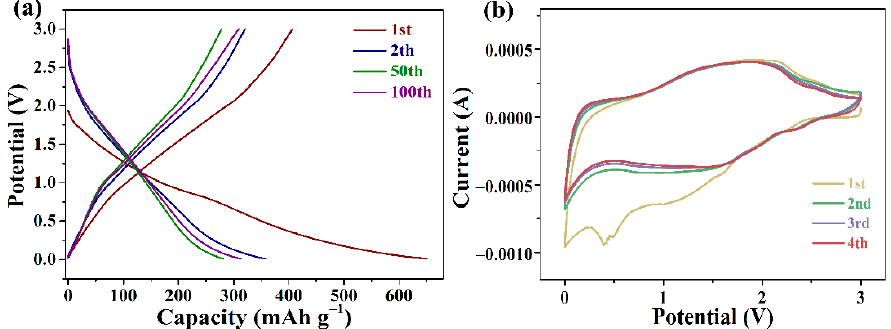
Figure 5. ( a ) Charge/discharge profiles at 0.1 A g − 1 of Ti 3 C 2 T x -T(O) anode; ( b ) CV curves at a scan rate of 2 mV s − 1 .